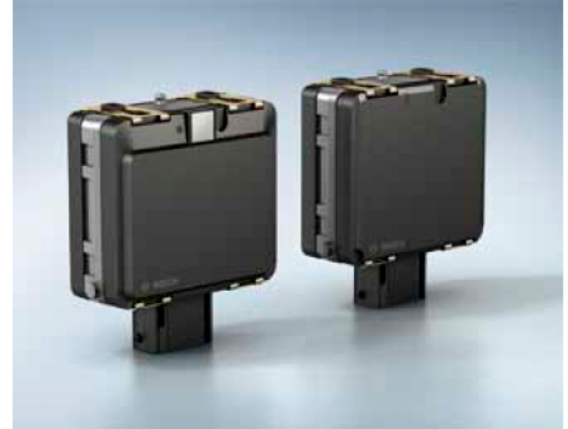
Figure 2. Mid-range radar from Bosch [68].